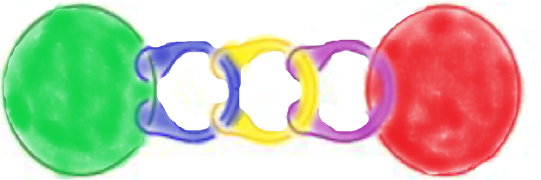
Figure 6. The entanglement structure of a Borromean chain in the topological